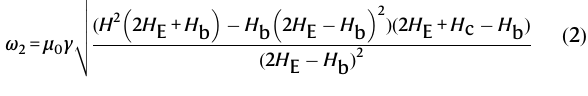
Fig. 3d. The Landau − Lifshitz model for A-type AFM vdW crystal lattices 43 has been carried out to fi t the frequency vs fi eld data at 10K, in order to determine the parameters of magnetic anisotropy in CCPS.